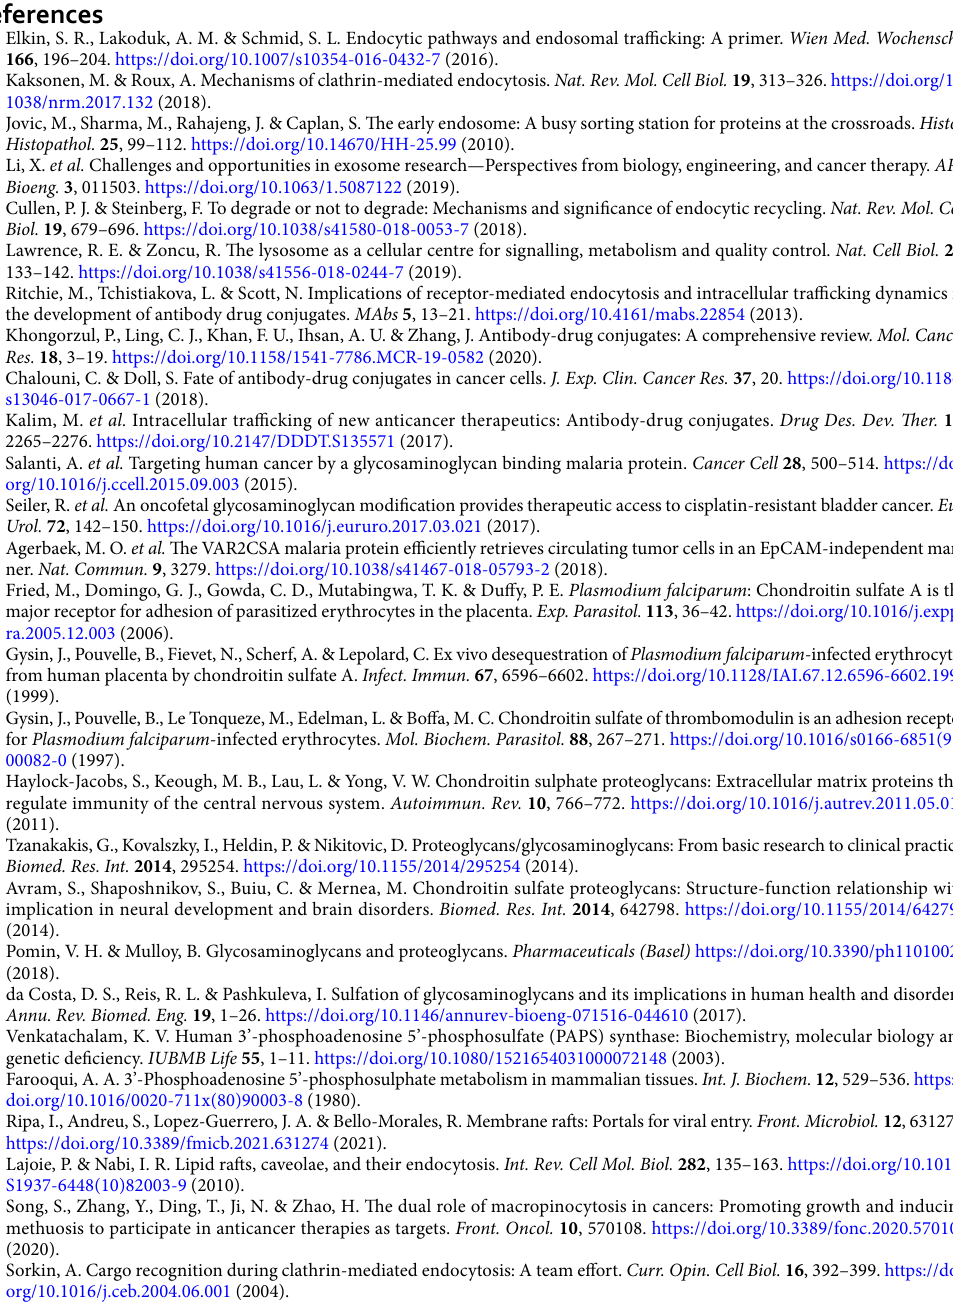
4e5, max injection time 50 ms in profile mode. MS2 parameters included precursor selection of 1.2 m/z, resolu- tion 15 K, intensity threshold of 5e4, charge state filtering 2–5, dynamic exclusion 15 s with 10 ppm tolerances, HCD fragmentation at 33%, fixed first mass of 110 m/z, AGC target of 5e4, and a max injection time of 100 ms in centroid mode with parallelizable time turned off. All data files were processed with Protein Discoverer 2.2.0.388. Spectrum files were recalibrated and features extracted with Minora. Searches were carried out with Sequest HT with SwissProt TaxID = 9606 (v2017-10- 25) with precursor mass tolerance 10 ppm and fragment mass tolerance 0.01 Da with C carbamidomethyl as permitted fixed and M,P oxidation as permitted dynamic peptide modifications and acetyl N -terminal protein modification. Decoy database strict and relaxed FDR targets were 0.01 and 0.05 based on q value. Precursor quantification was intensity based with unique and razor peptides used, normalizing on total peptide amount with scaling on all average, and protein lists exported to Excel for any further